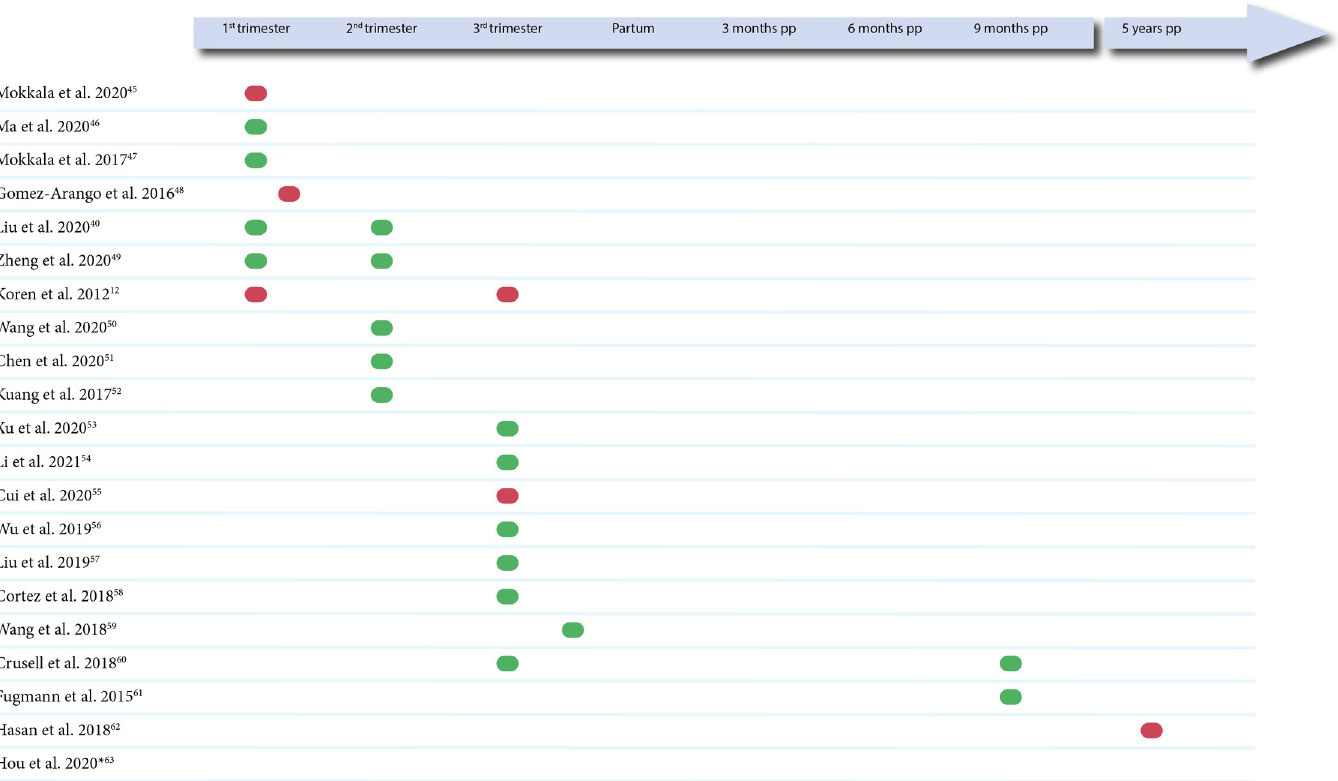
Fig 2. Time-point for microbiota analyses. Green symbol indicates that the study found a statistically significant difference between GDM and non-GDM women in either alpha diversity, beta diversity, or relative bacterial abundance. Red symbol indicates that the study did not find a statistically significant difference between the GDM and non-GDM women. The level of significance for each study can be seen in Table 2. � No information regarding the time-point for microbiota